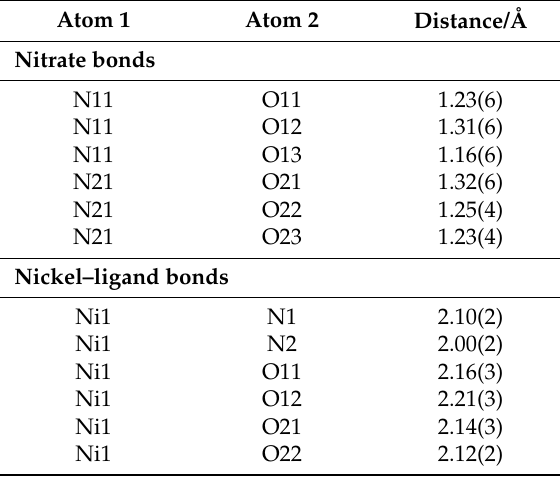
Table 3. Interatomic distances in Ni(NH 3 ) 2 (NO 3 ) 2 .